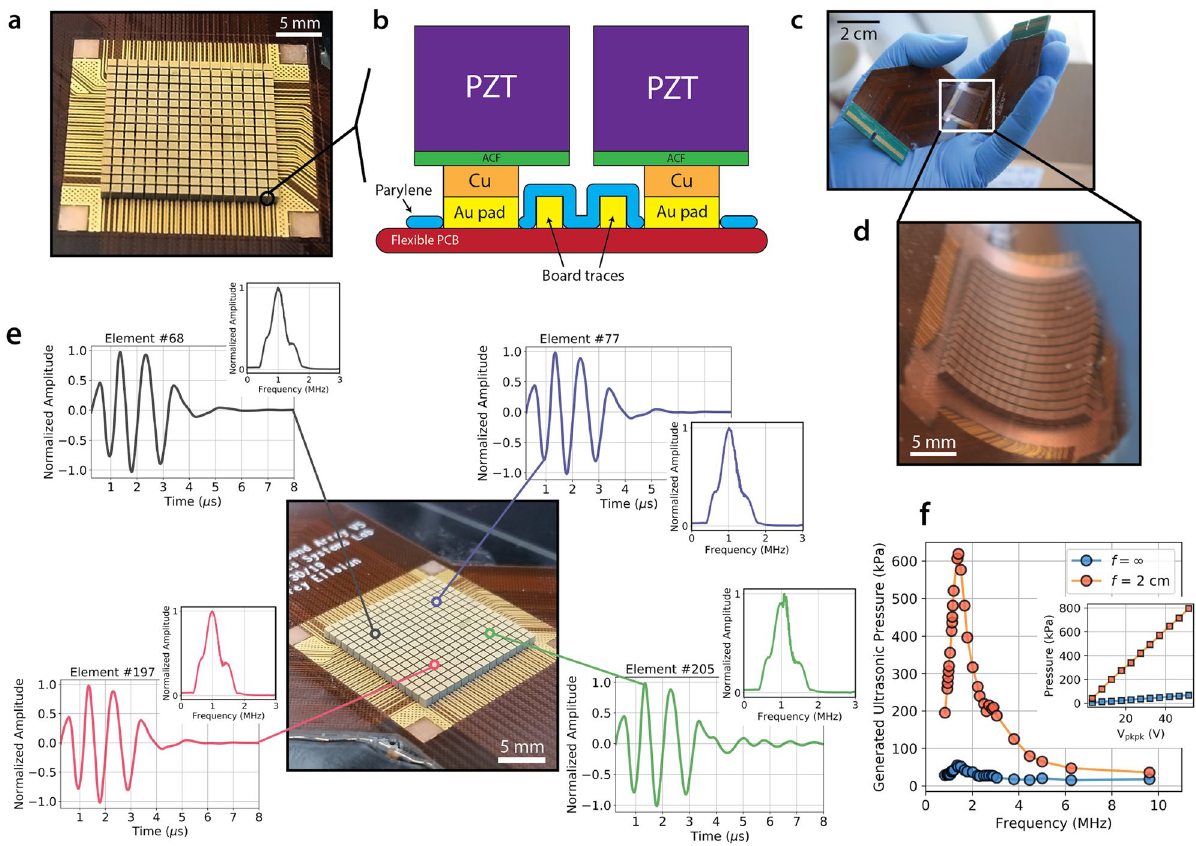
Figure 2. PZT pillar fabrication and ultrasound performance benchmarks of the FlexArray. ( a ) Photograph of the bonded PZT array quarters after back-side dicing to separate out the individual transducer pillars. ( b ) Cross-sectional illustration (not to scale) of the finalised pillar mount. Cu electroplating is used to raise the metal connection before bonding with the bulk PZT transducer on the ACF substrate. Parylene isolates the signal pads from the electrical traces on the board. ( c ) Photograph of the completed FlexArray, relative to a human hand. ( d ) Close-up photograph of a bent piezoelectric array in the center of the device after metallisation and encapsulation. ( e ) Examples of pulse-echo responses, and their associated frequency spectra as insets, from arbitrary pillars in each quarter of the array. The temporal envelope for three pulses is ~ 4 μs with a wide bandwidth of ~ 41%. ( f ) Ultrasonic pressure generated by the FlexArray in water when focused at f = ∞ (blue) and at f = 2 cm (red), across a range of ultrasound frequencies. The pressure value peaks at over 600 kPa. The inset shows the linear scaling of the generated ultrasonic pressure with applied peak-to-peak voltage across the transducer